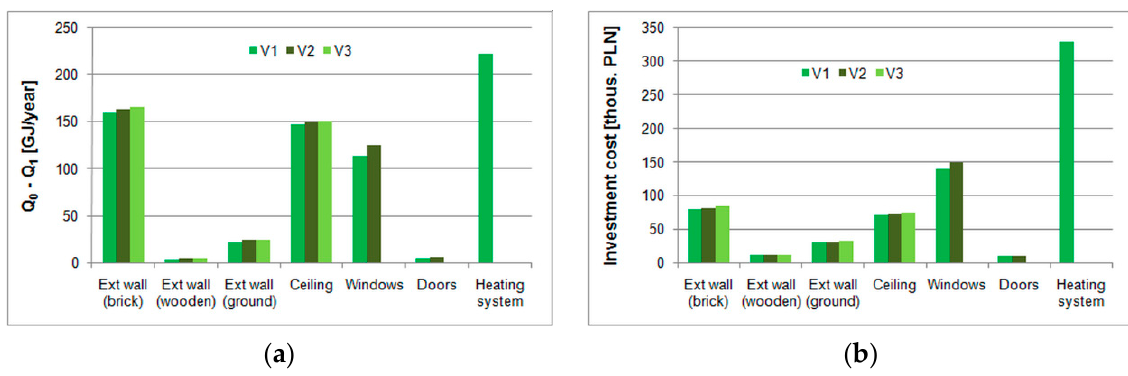
Figure 5. Modernisation variants. ( a ) Energy savings of the individual measures. ( b ) Investment costs of individual measures.